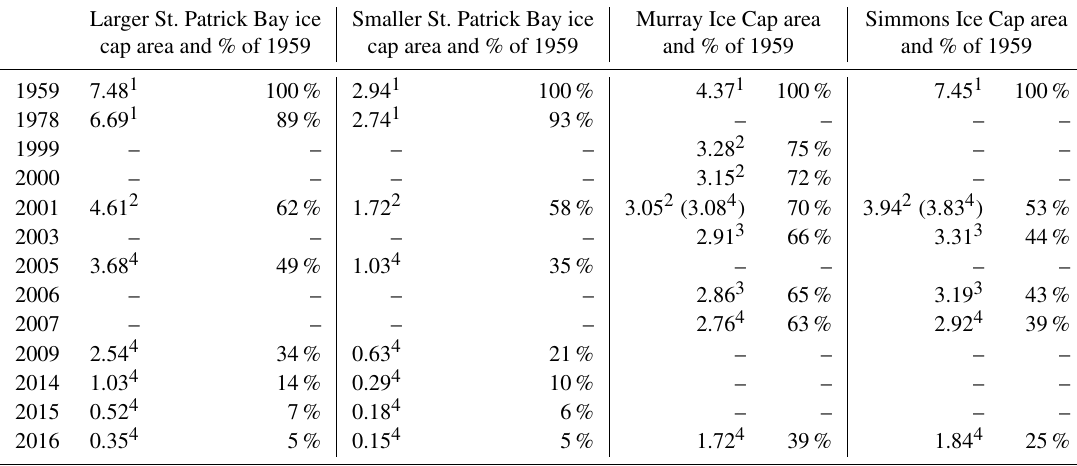
Table 2. Surface areas (km 2 ) and % areas compared to 1959 aerial